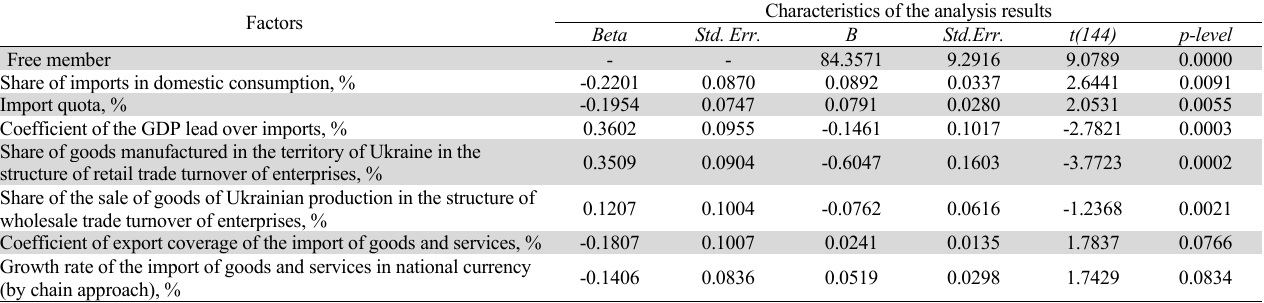
Information on the results of the regression analysis of the impact of import dependency indicators on Ukraine’s economic security in